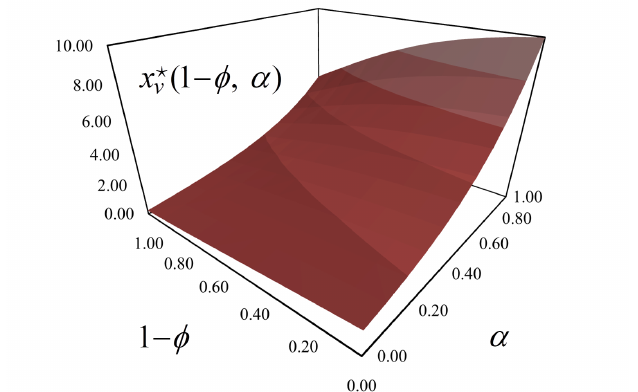
Figure 8. Nash bargaining solution ( x (cid:63) v ) with social preferences. The left-sided x -axis corresponds to the share of v (1 − φ ). The right-sided y -axis is the decay parameter ( α ). The z -axis denotes Nash allocations ( x (cid:63) v ( 1 − φ , α ) ).